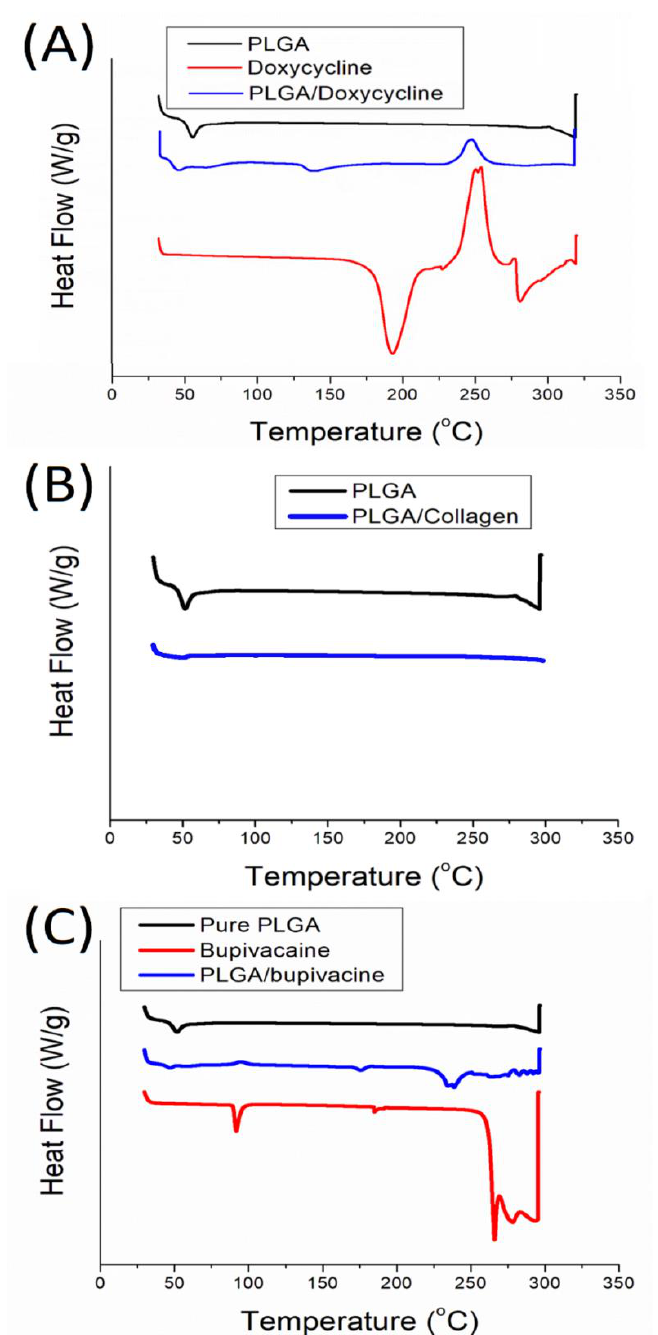
Figure 4. Thermograms of ( A ) doxycycline-loaded nanofibers, ( B ) collagen-loaded nanofibers, and ( C ) bupivacaine-loaded nanofibers.